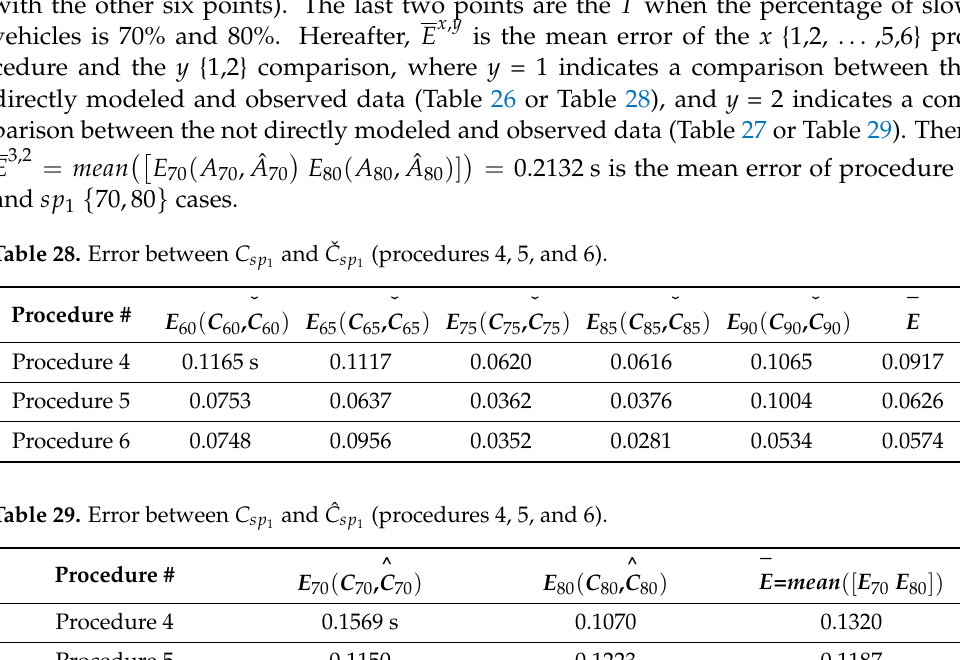
Table 29. Error between C sp